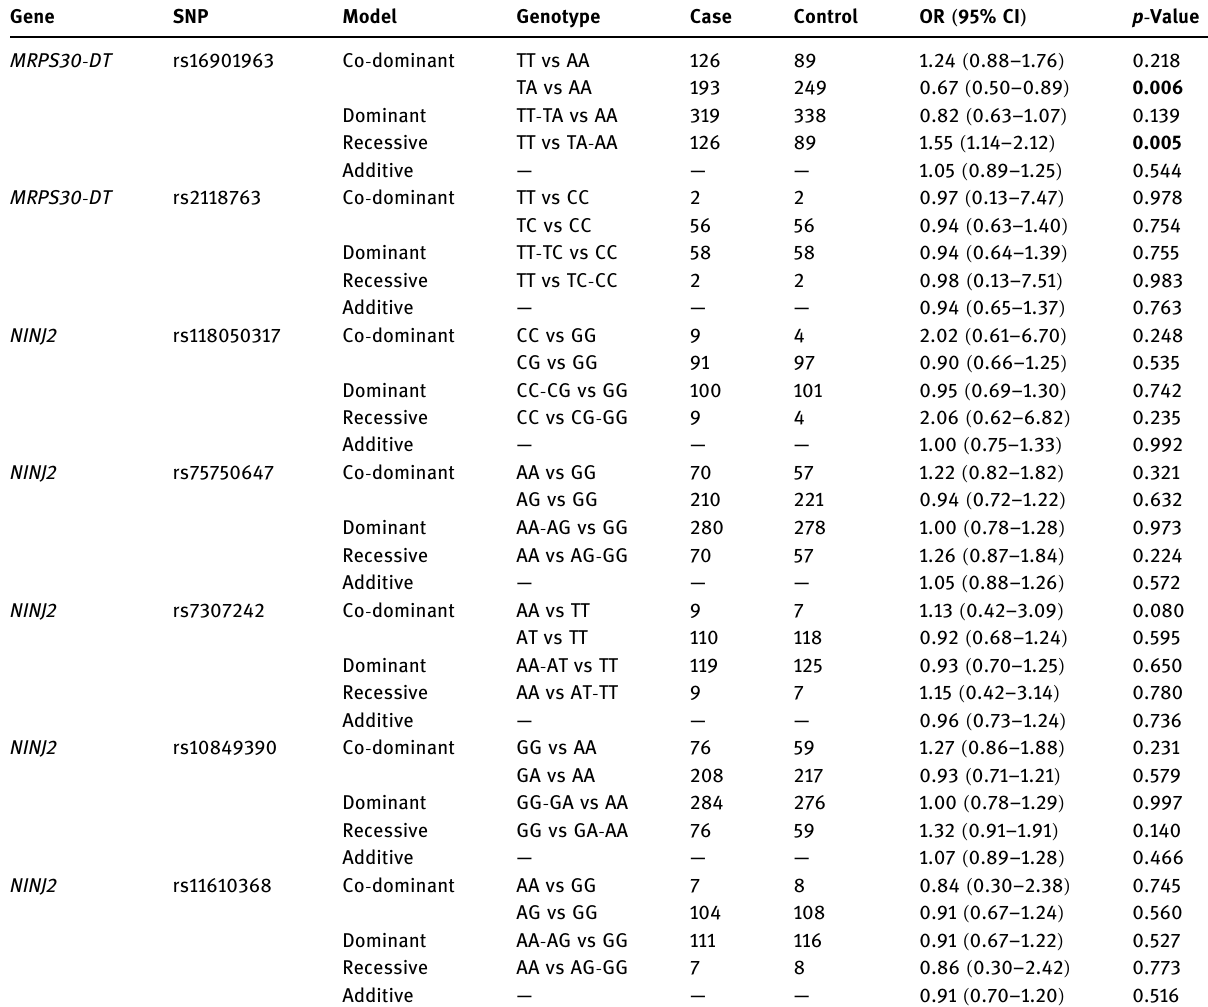
Table 3: Association of MRPS30 - DT and NINJ2 genetic polymorphisms with lung cancer risk